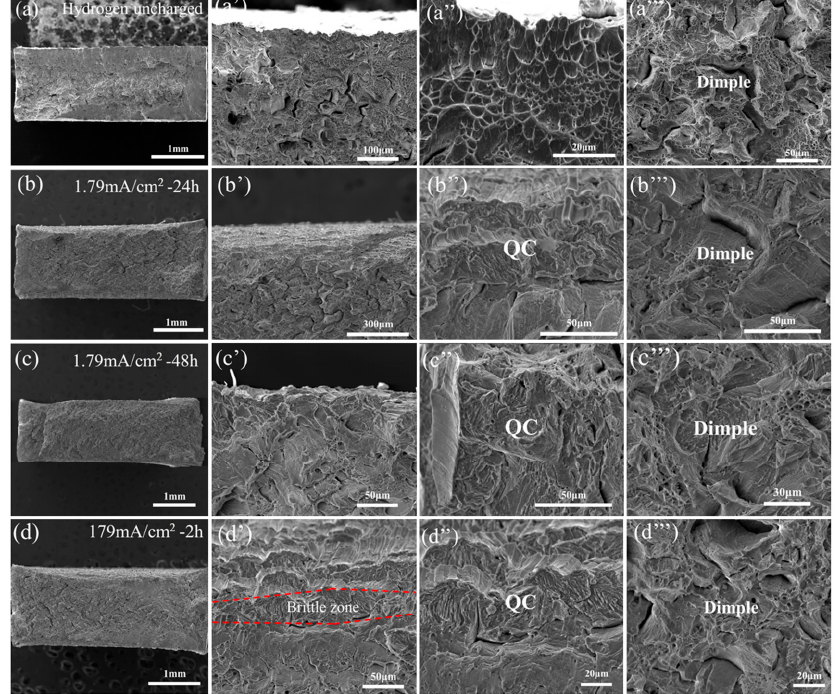
Figure 5. SEM images of fractured hydrogen-charged and uncharged samples of 304 SS subjected to various charging parameters viewed from top side. ( a – a ′′′ ) uncharged; ( b – b ′′′ ) 1.79 mA cm − 2 for 24 h; ( c – c ′′′ ) 1.79 mA cm − 2 for 48 h; ( d – d ′′′ ) 179 mA cm − 2 for 2 h. QC: quasi-cleavage fracture.